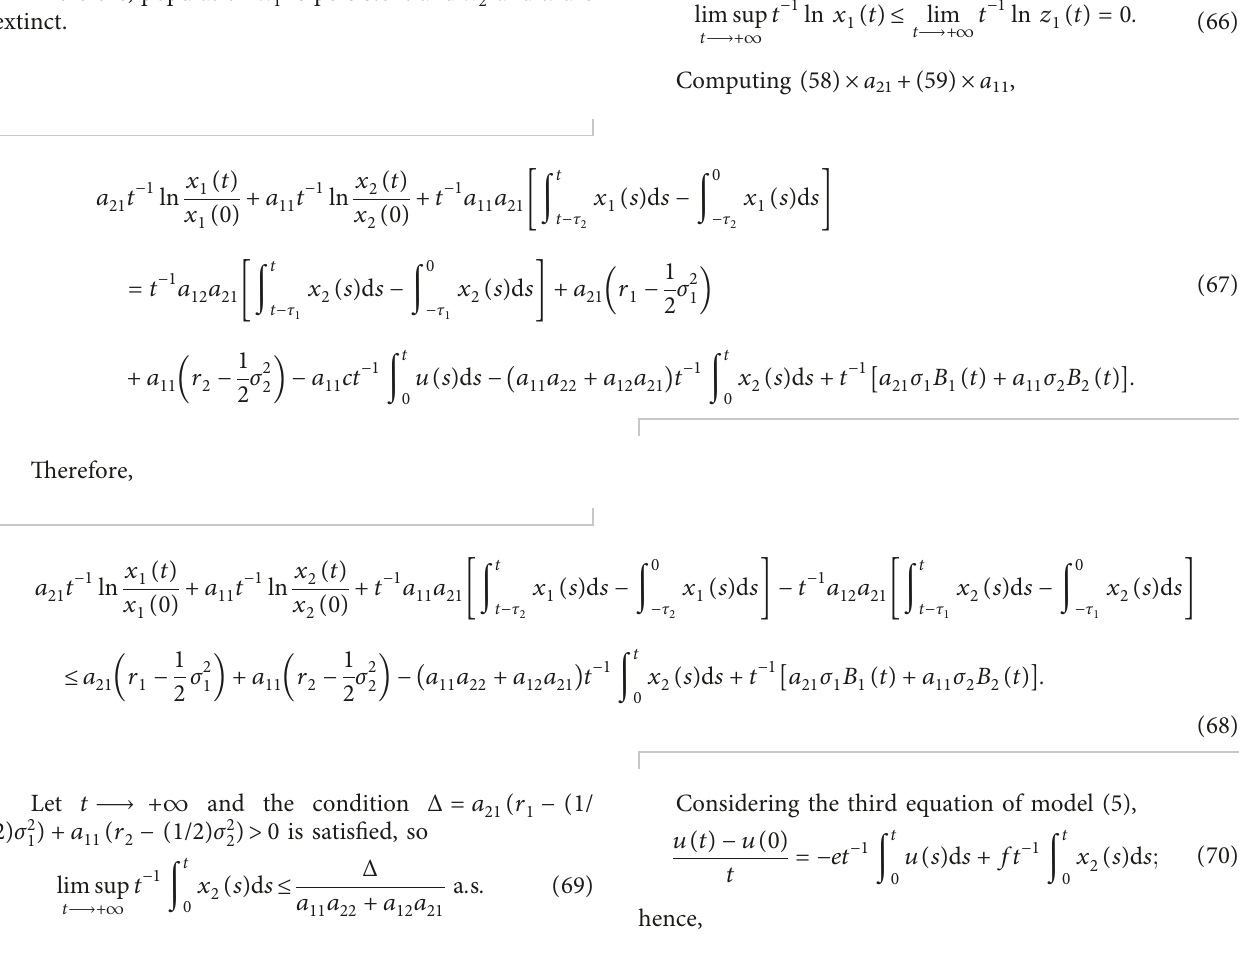
( t ) , x ( t ) , u ( t )) . (b) Phase diagram of ( x 1 2